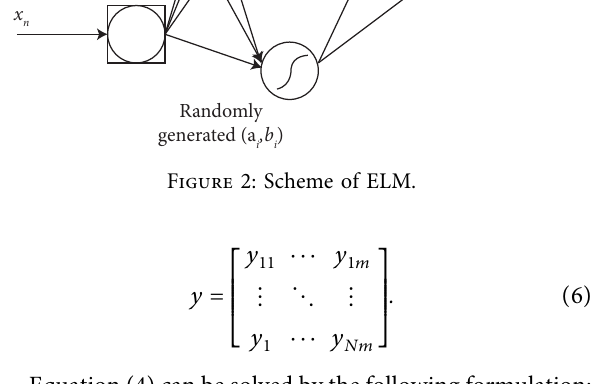
Figure 2: Scheme of